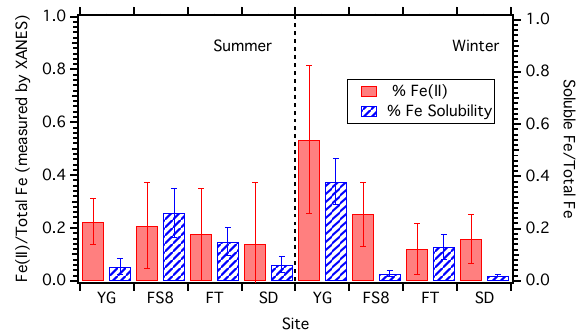
Fig. 6. Total (soluble+insoluble) Fe(II) (Fe(II)/Total Fe) measured by XANES (red bars) and fractional iron solubility (blue hatched bars) content in each filter sample. Error bars represent the ± 1 σ